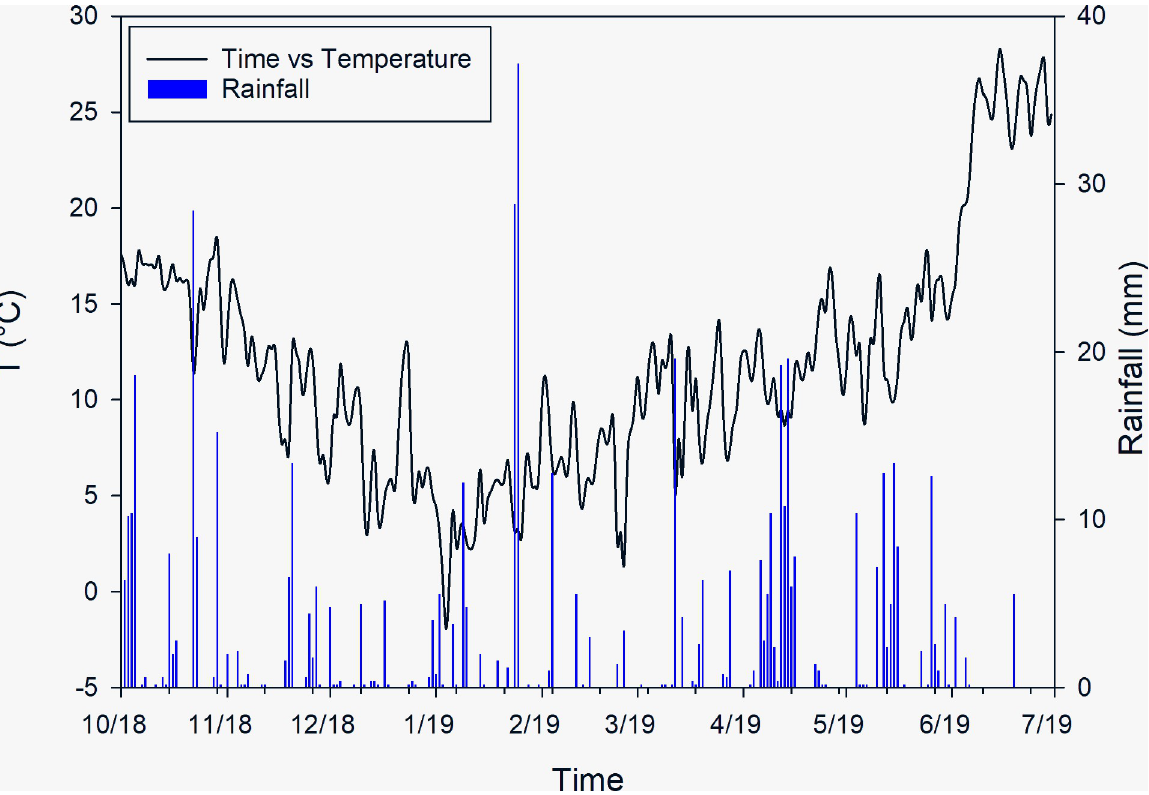
Fig 4. Weather conditions. Monthly average precipitation and temperature during the study period of winter wheat growing cycle (October 2018 to June 2019).